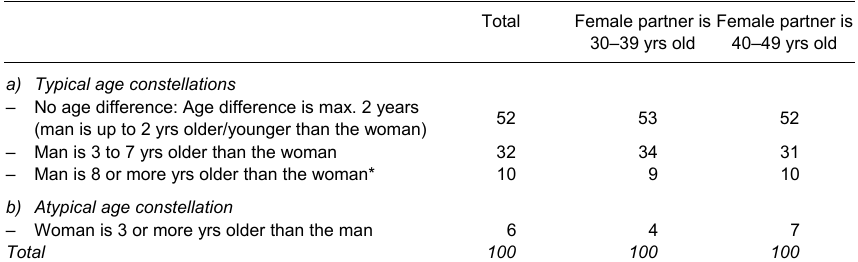
Age constellations in German academic couples, 2004 (in rounded column